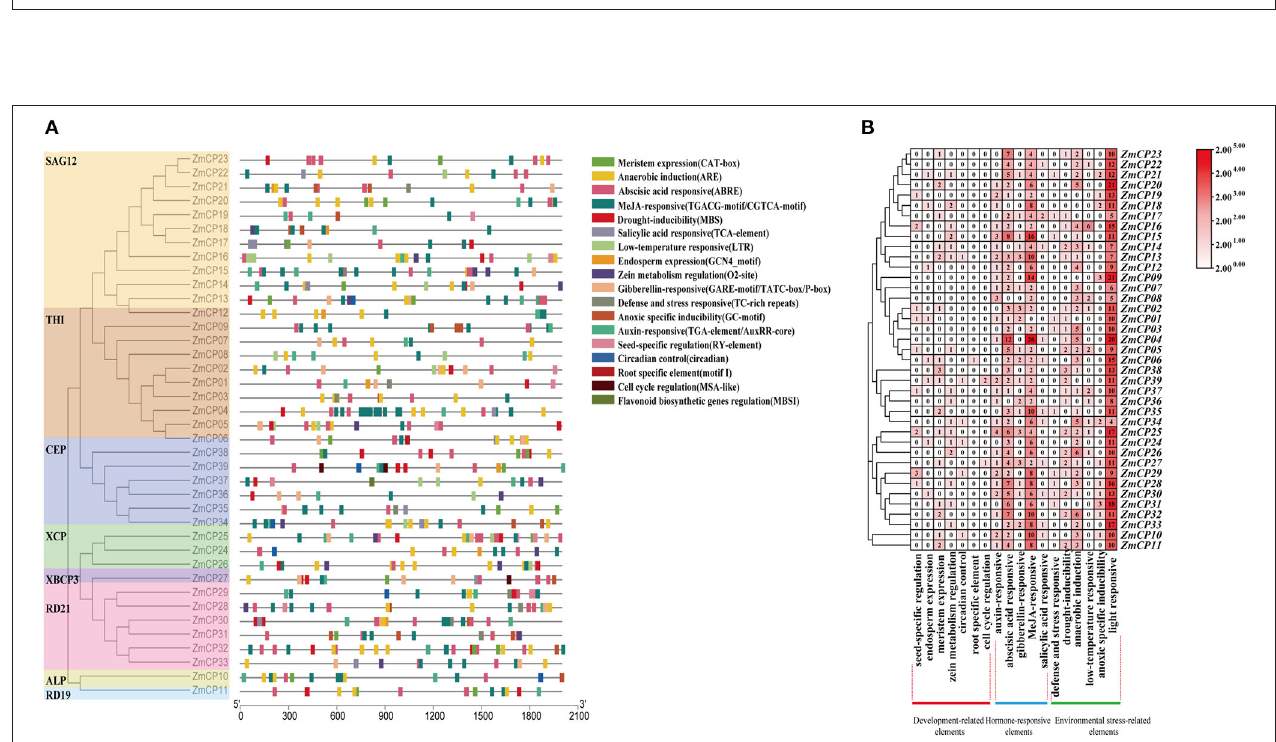
FIGURE 3 | Promoter cis- elements analysis of ZmCP genes. (A) The position of elements in ZmCP promoters. (B) The number of occurrences cis-elements in the promoter region of ZmCP genes.